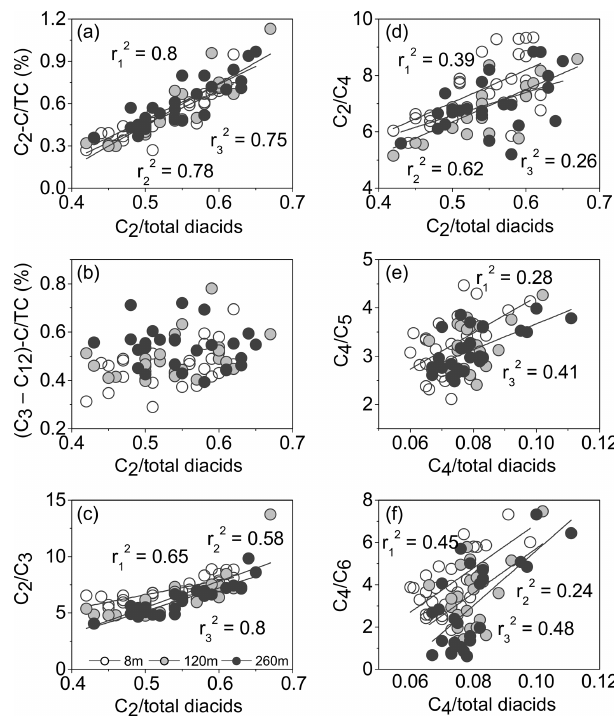
Figure 7. Contributions of (a) C 2 − C / TC (%), (b) (C 3 − C 12 ) − C / TC (%), (c) C 2 / C 3 and (d) C 2 / C 4 ratios as a function of relative abundance of C 2 in total diacids, as well as correlations for C 4 / total diacids with (e) C 4 / C 5 and (f) C 4 / C 6 . The r 2 , r 2 and r 2 values are the correlation coefficients for those 1 2 3 samples collected at 8, 120 and 260m,